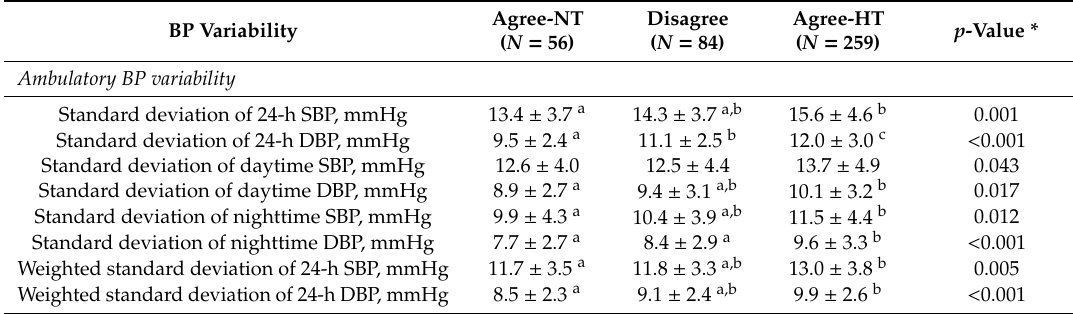
Table 6. Comparisons of the blood pressure variability.